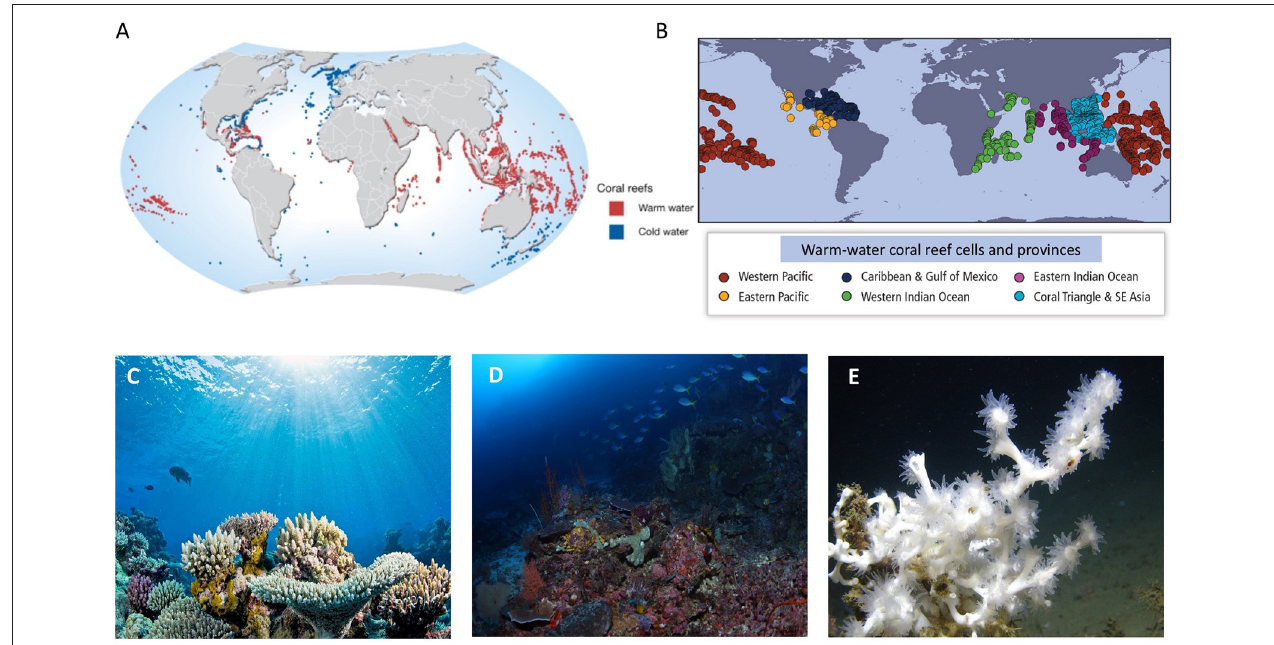
FIGURE 1 | (A) Distribution of warm-water and cold-water coral reefs (credit: Hugo Ahlenius, 2008, UNEP/GRID-Arendal, http://www.grida.no/resources/7197). (B) Location of warm-water coral reef cells and provinces, from Hoegh-Guldberg et al. (2014). (C) Warm-water carbonate coral reef from the Great Barrier Reef, Australia (credit: Ove Hoegh-Guldberg). (D) Mesophotic coral community of North Sulawesi, Indonesia. (Credit: Pim Bongaerts, University of Queensland). (E) Deep-water community of Lophelia pertusa from the Mississippi Canyon at ∼ 450m depth (Image from NOAA, licensed under the Creative Commons Attribution-Share Alike 2.0 Generic